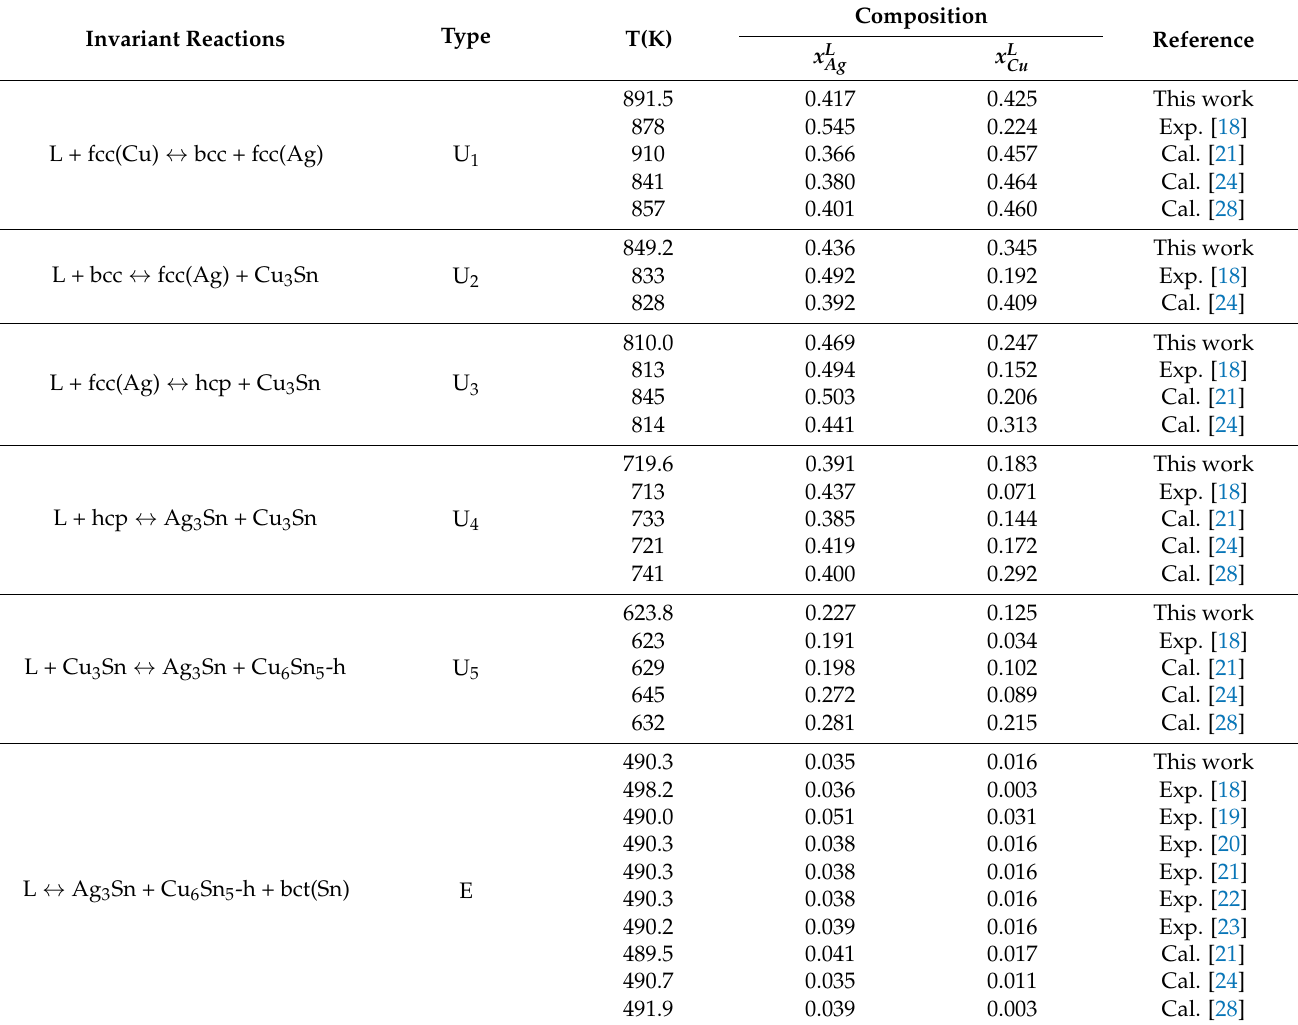
Table 3. Invariant reactions in the Ag-Cu-Sn ternary